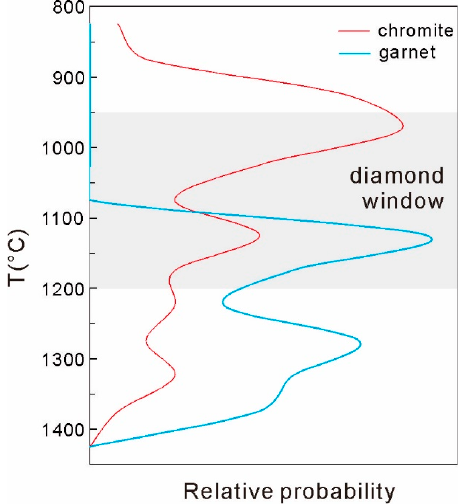
Figure 5. Temperature (depth) distribution of xenocrystic garnets and chromites from the No.30 kimberlite. Equilibrium temperatures of garnets [27] are calculated using the Ni-in-garnet thermometer [53] , and equilibrium temperatures with the cores of xenocrystic spinels are estimated using Zn-in-chromite thermometer [15].